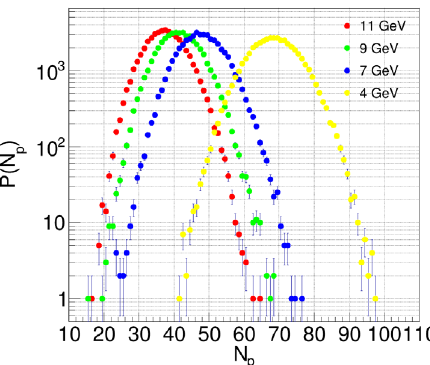
Figure 6: MPD phase-space plot for protons (TPC + TOF)